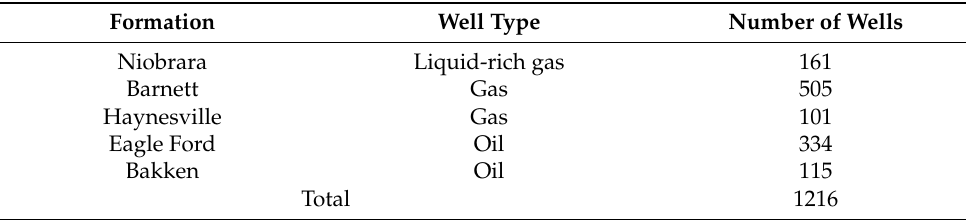
Table 1. Number of wells collected and used from each formation.